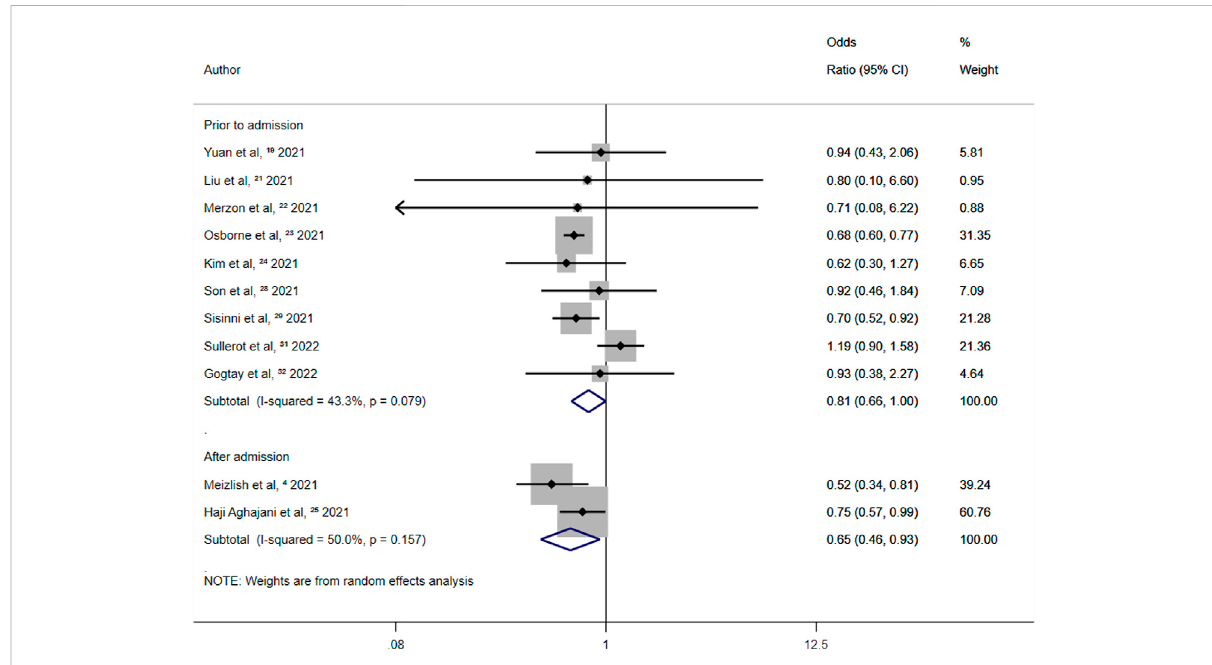
FIGURE 6 Summary odds ratio of all-cause mortality for aspirin use after admission and prior to